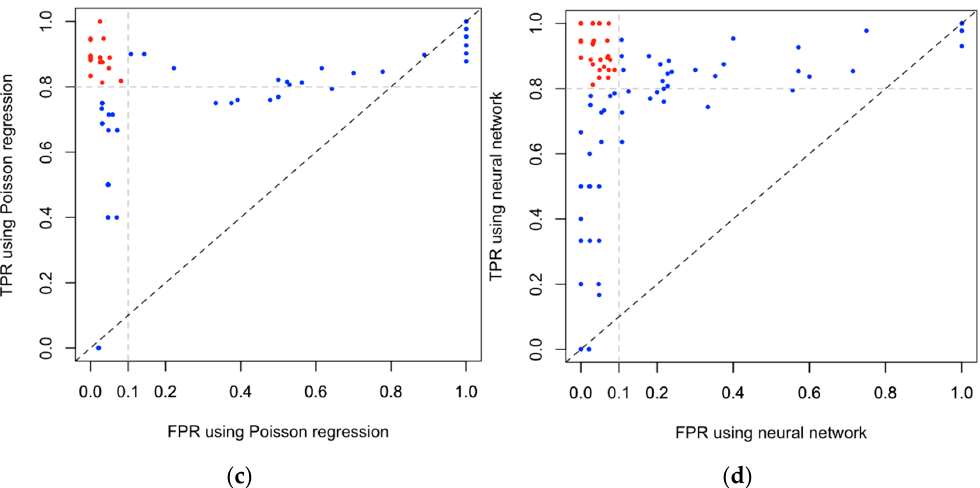
Figure 5. Extreme spring drought (ESD) frequency over CDR ( a ) using Poisson regression; and ( b ) neural networks. Receiver Operating Characteristics (ROC) evaluation for prediction results of ( c ) Poisson regression; and ( d ) neural networks.